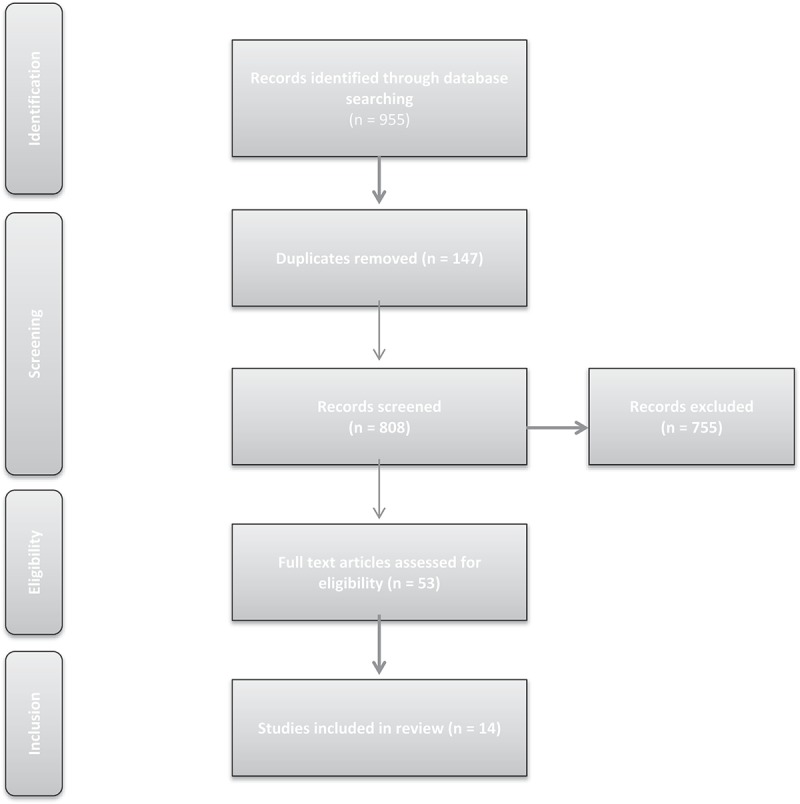
Data search methods.